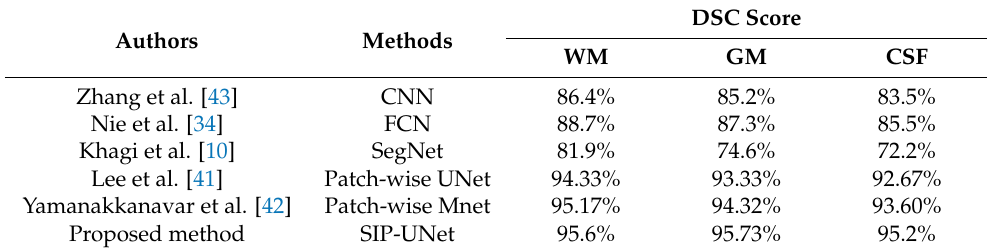
Table 5. Comparison of different approaches for brain structure